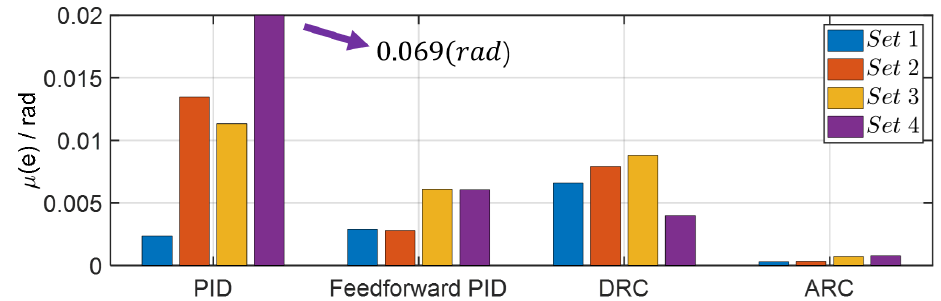
Figure 8. Average tracking error in 4 controllers.